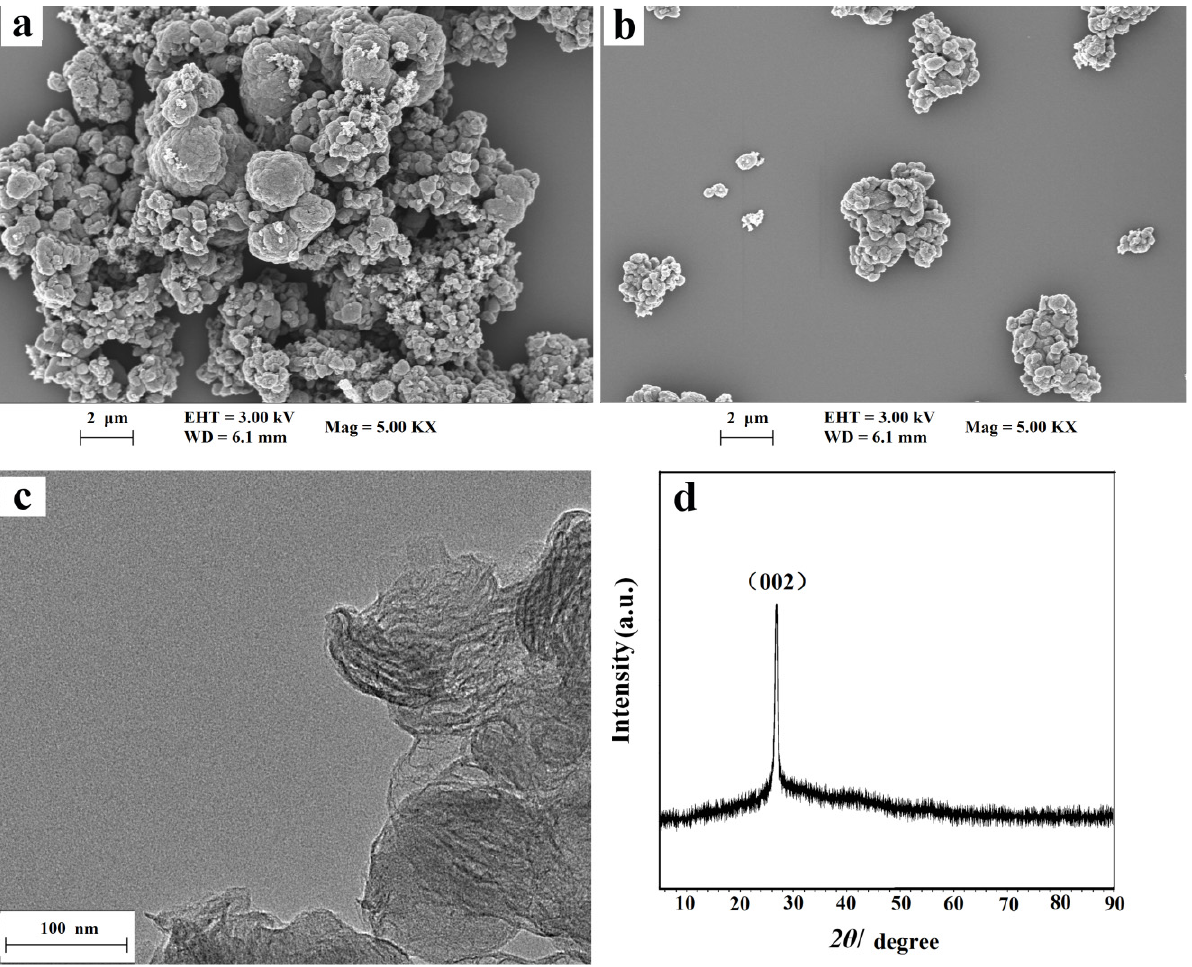
Figure 1. SEM images of NC nanohybrid ( a ) and NC–PEI composite ( b ); TEM image of NC nanohy- brid ( c ) and XRD pattern of NC nanohybrid ( d ).